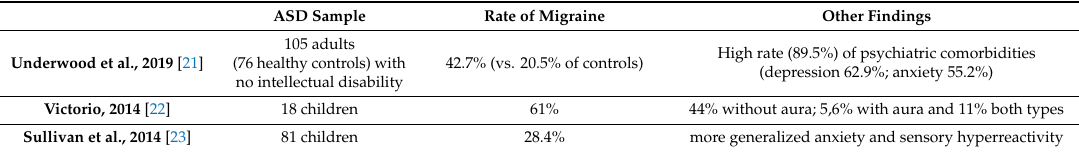
more generalized anxiety and sensory